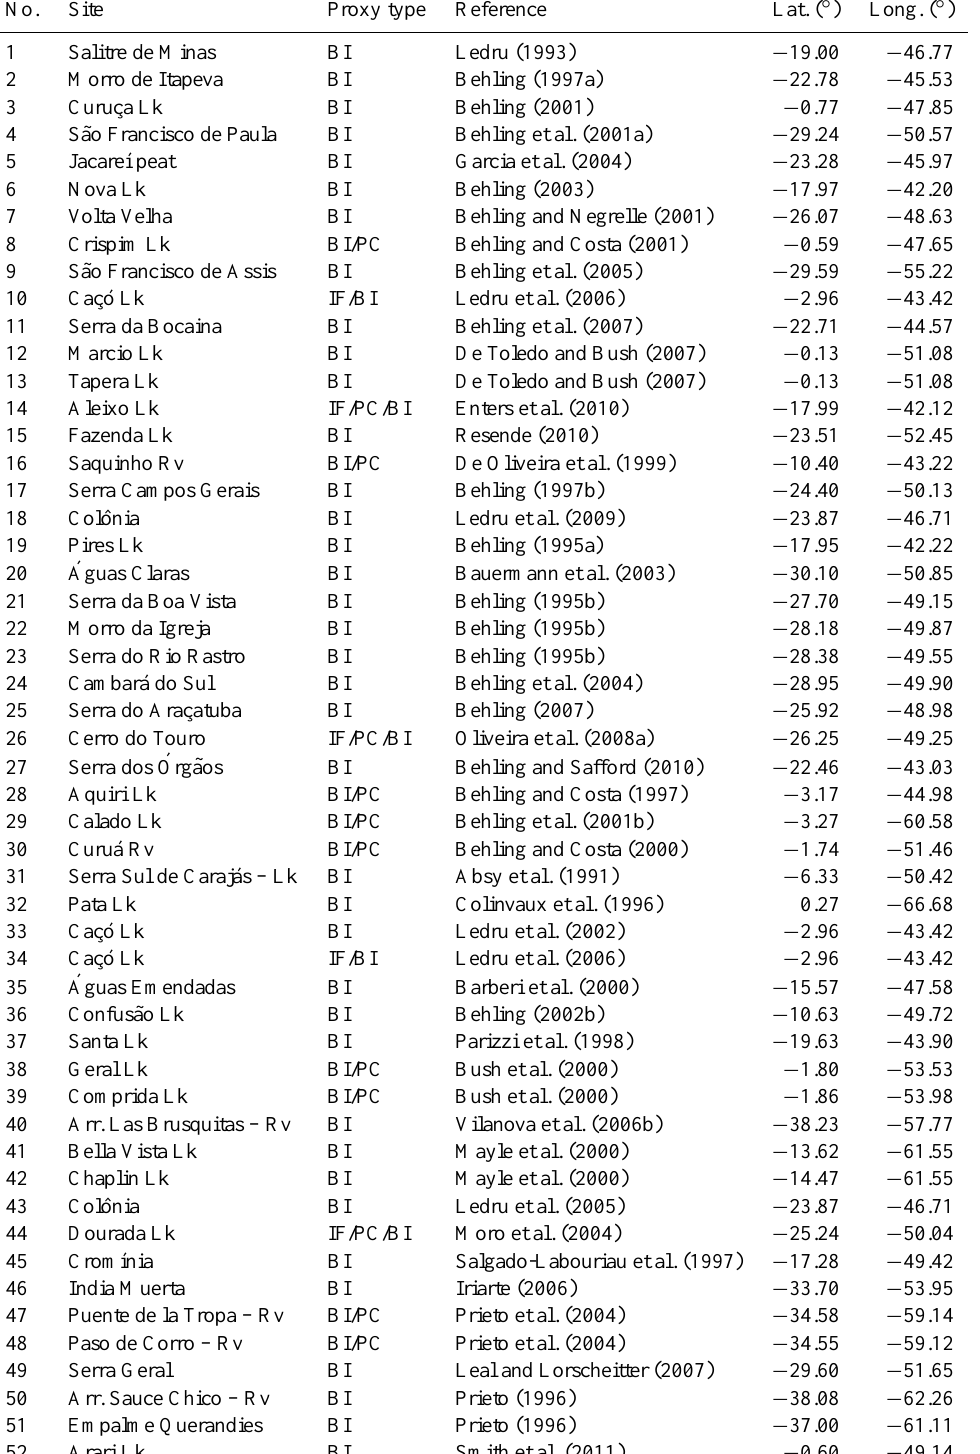
Table 2. Locations and references of the palaeoclimatic records used in this study ∗ . Abbreviations are as follows. Site: Lk = lake, Cv = cave, Rv = river; proxy type: IF = isotopic fractionation, PC = physico-chemical, BI = biological. Numbers within parentheses in the “Site” column – in records 72, 77, 90, 95, 112, and 113 – refer to total of samples collected at the referred site. More details of proxy type can be found in Table